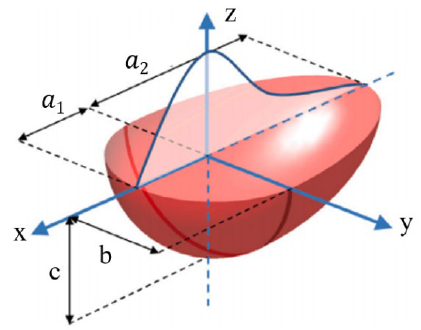
Figure 5. Double ellipsoid heat source model. Table 3. Double ellipsoid heat source parameters.